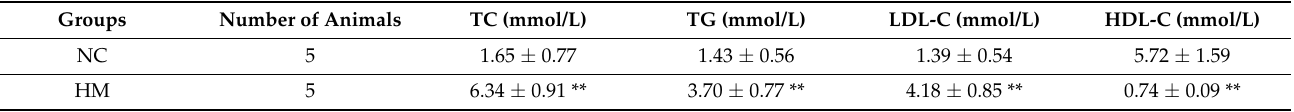
Table 1. Effects of a 28 d high-fat diet on mouse blood lipid levels (x ± SE; n = 5).